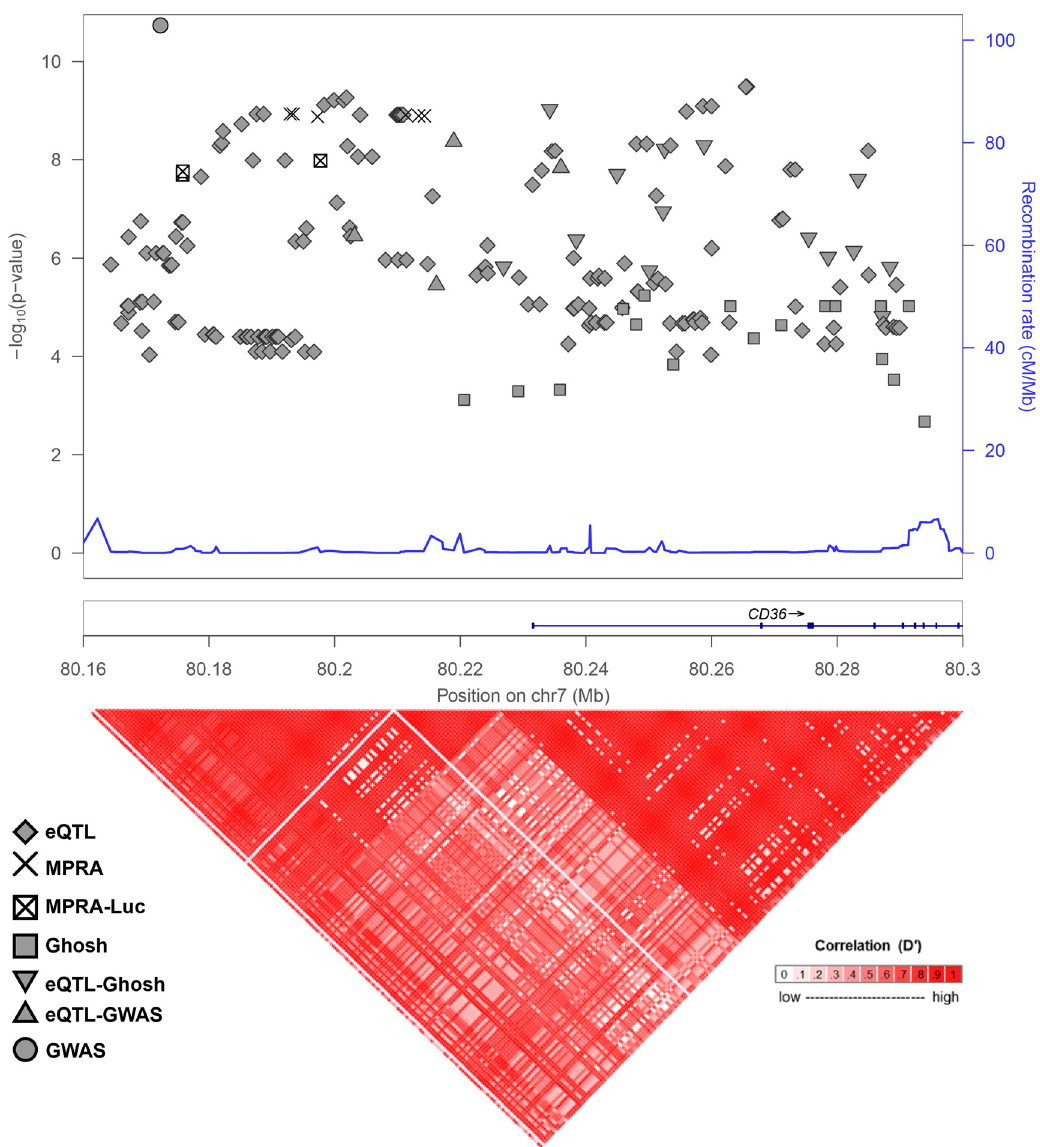
Fig 1. Genomic context of CD36 variants. (Upper) Manhattan plot of CD36 variants identified as platelet eQTLs only (diamonds), associated with CD36 surface levels (squares), GWAS-implicated (circle), eQTLs and CD36 surface level associated (upside down triangle), eQTLs and associated with GWAS-implicated (triangle), eQTLs and functional in MPRA assay (X’s), or eQTLs functional in MPRA assay and validated by luciferase (squared X).–log 10 P-values are significance of eQTL association, if available, or from CD36 surface level association. GWAS-implicated variant (circle) is associated with platelet count (P = 2 x 10 − 17 ) and vertical position does not represent significance. (Lower) LD-plot of genomic locus with D’ values calculated with 1000 genomes JPT (Japanese)